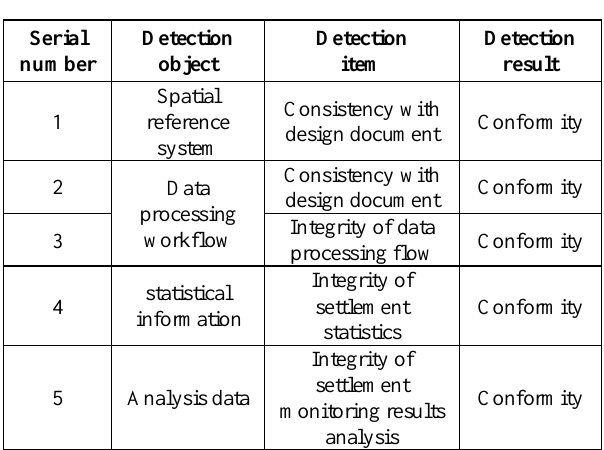
Table 2. The inspection results of data integrity